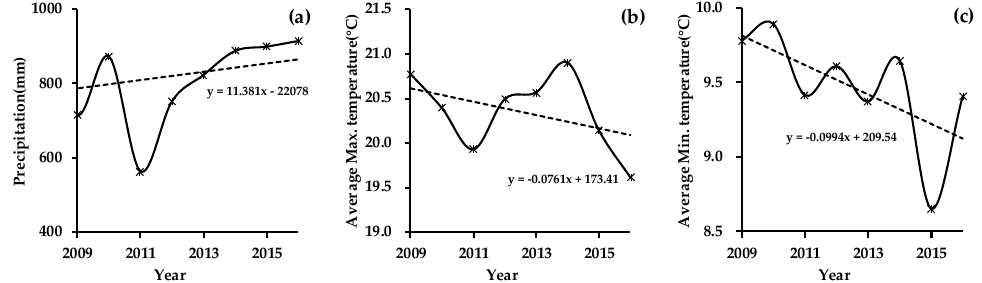
Figure 9. Changes in annual precipitation ( a ), average Maximum temperature ( b ) and average Minimum temperature ( c ) from 2009 to 2016;